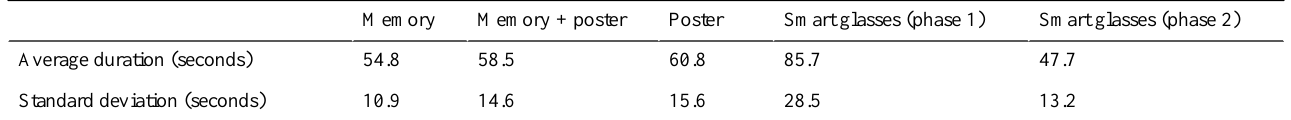
47.785.760.858.554.8Average duration (seconds) 13.228.515.614.610.9Standard deviation